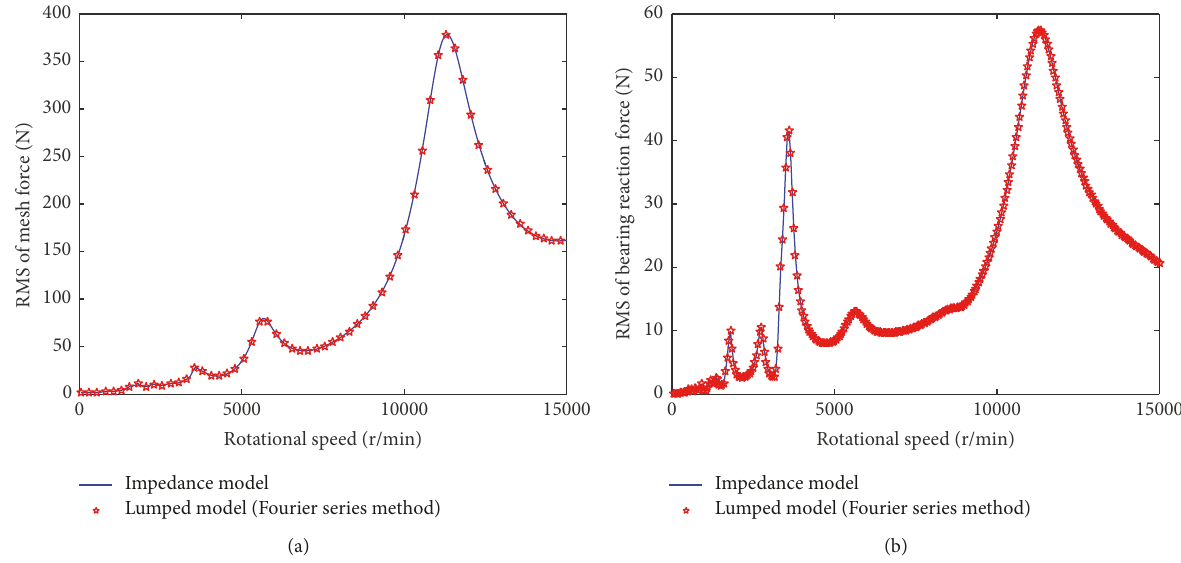
Figure 8: Comparison between impedance model and lumped parameter model: (a) RMS of mesh force; (b) RMS of bearing reaction load.